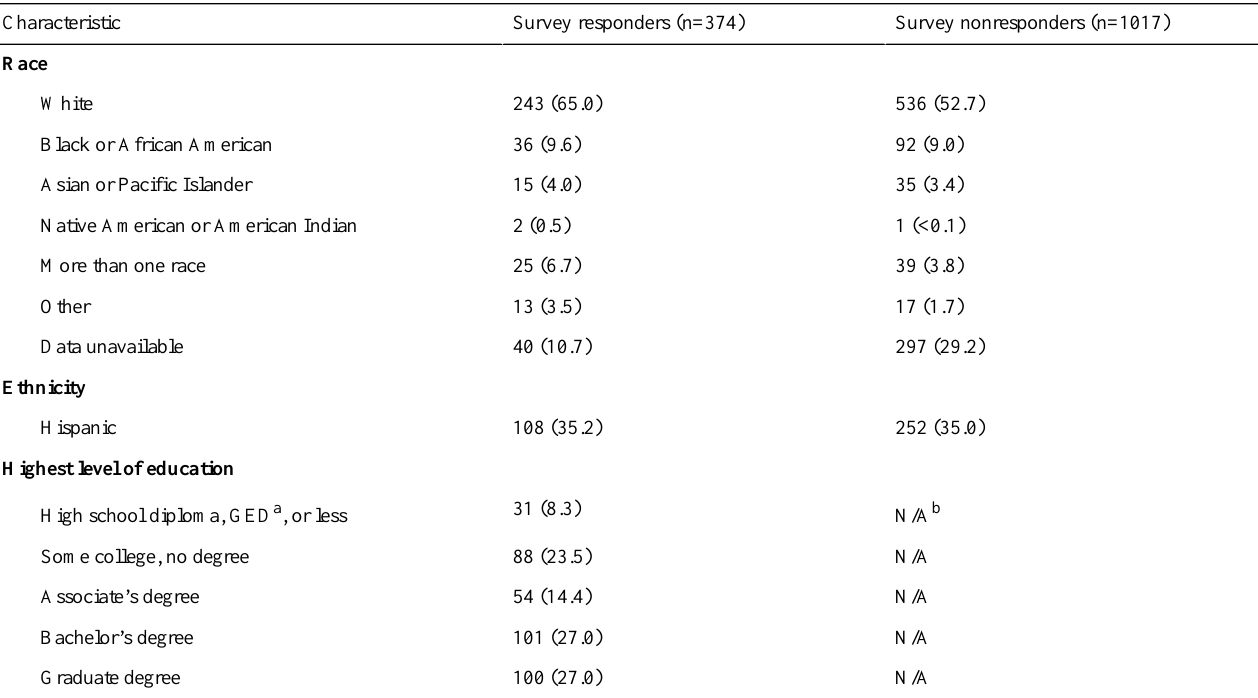
Table 1. Demographics of the survey recipients (N=1391), n